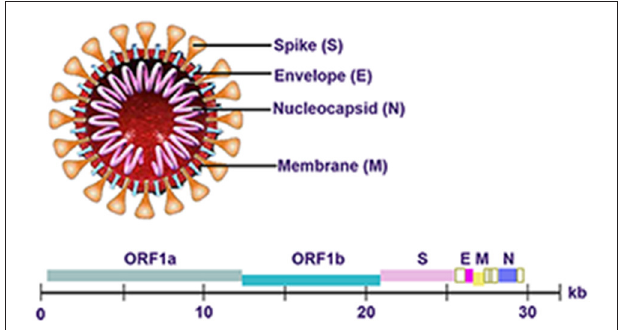
FIGURE 1 | Genome of SARS-CoV-2.